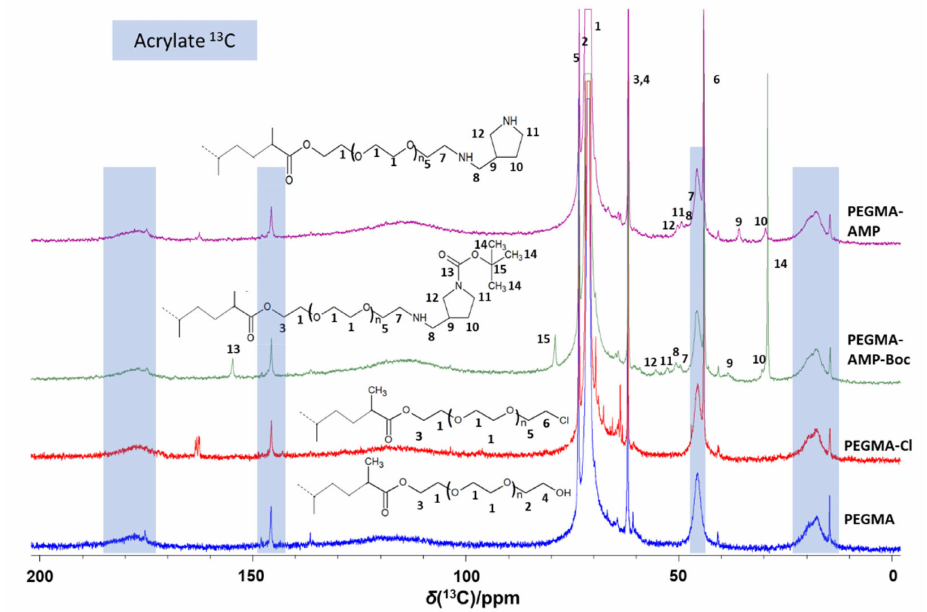
Figure A6. 13 C NMR spectra of (from bottom to top) the PEGMA support, the chlorine-functionalized PEGMA-Cl, the protected amine-functionalized PEGMA-AMP-Boc-3 and the aminated PEGMA- AMP-3. The spectrum is scaled vertically to magnify the diamine